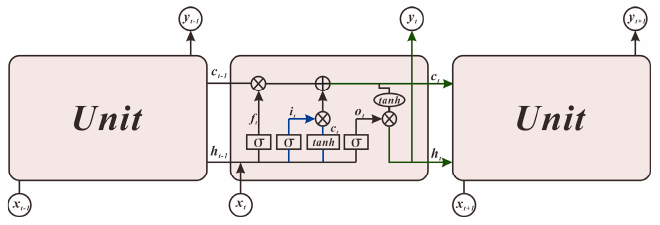
Figure 5. The internal structure of the LSTM neural network unit.